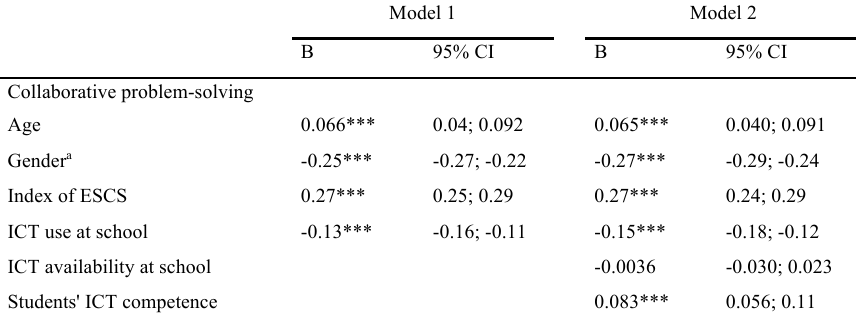
The standardized coefficients (B) with 95% confidence intervals of the ICT variables, when predicting students’ performance in scientific literacy, mathematical literacy, reading literacy, and collaborative problem-solving with structural equation models